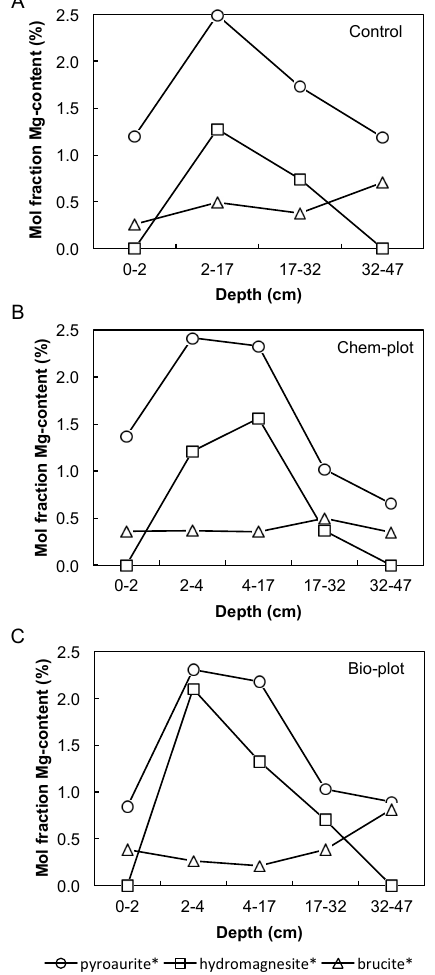
Figure 7. Mole fraction of the Mg content in pyroaurite, hydromagnesite, and brucite in the ( A ) unreacted, control tailings; ( B ) Chem-plot; and ( C ) Bio-plot.